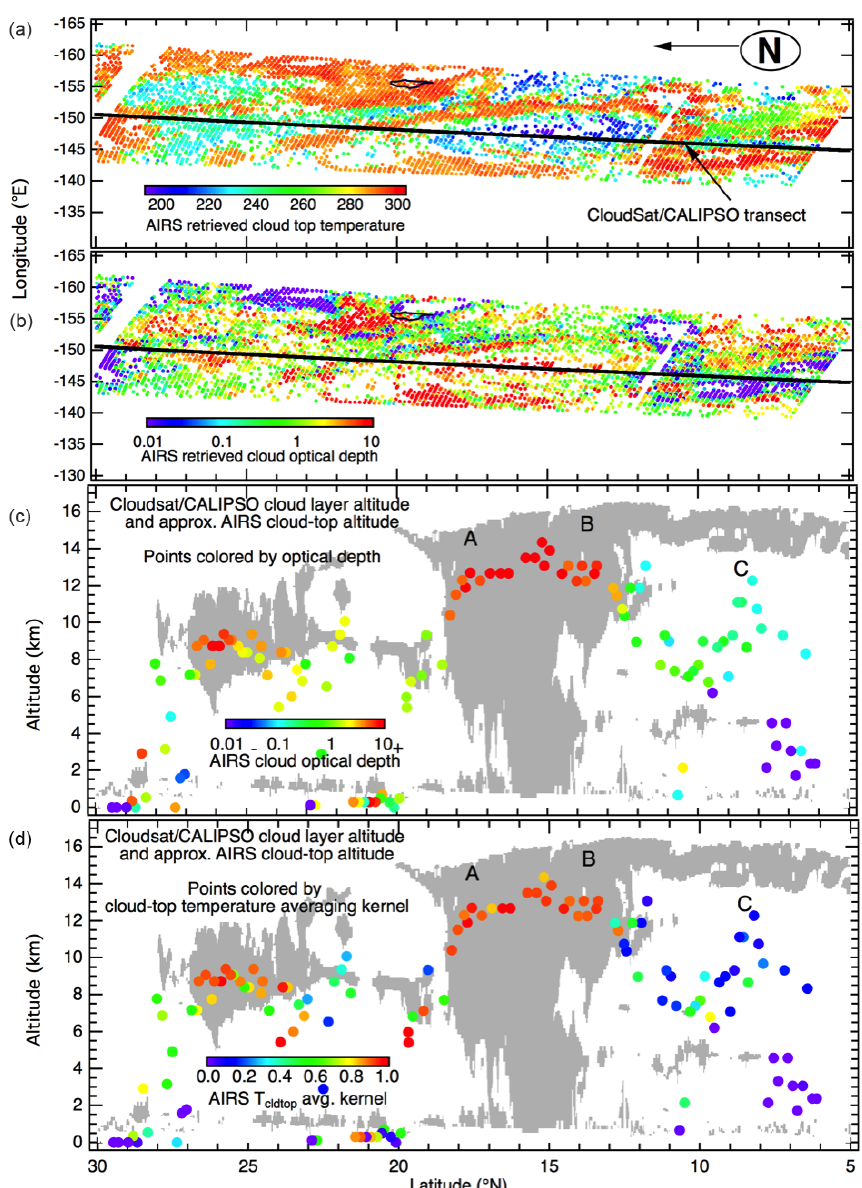
Figure 7. Comparison of AIRS-OE approximate cloud-top altitude with CloudSat/CALIPSO (CsC). (a) AIRS-OE cloud-top temperature with CsC transect. (b) AIRS-OE cloud optical depth. (c) CsC cloud layer altitudes (grey) with approximate AIRS-OE cloud-top altitudes, colored by retrieved optical depth. (d) Same as third panel but points colored to show cloud-top temperature averaging kernels. Data are from daytime observations, 31 July 2009 over the Pacific